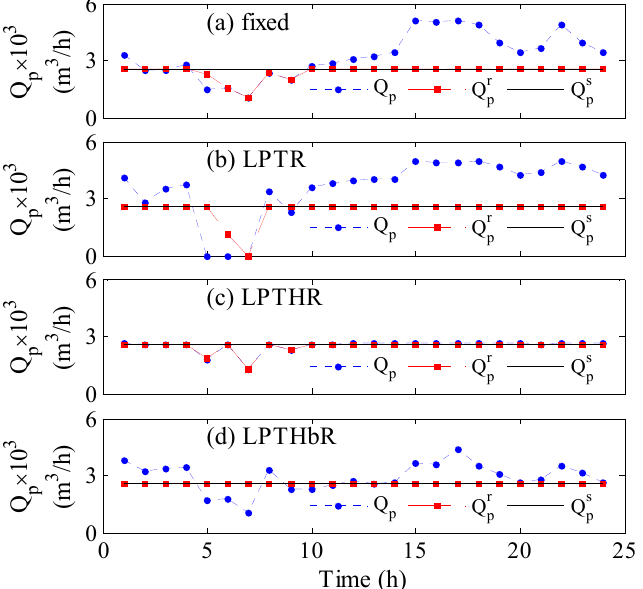
Figure 2. Time response of the production rate; ( a ) no control, ( b – d ) using optimal control with different objective functions.